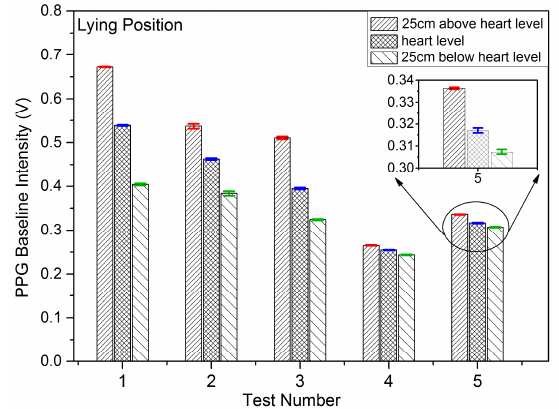
Figure 8. PPG baseline amplitudes and standard deviations when the subjects were in the lying position and the finger sensor probe set at three different vertical levels.